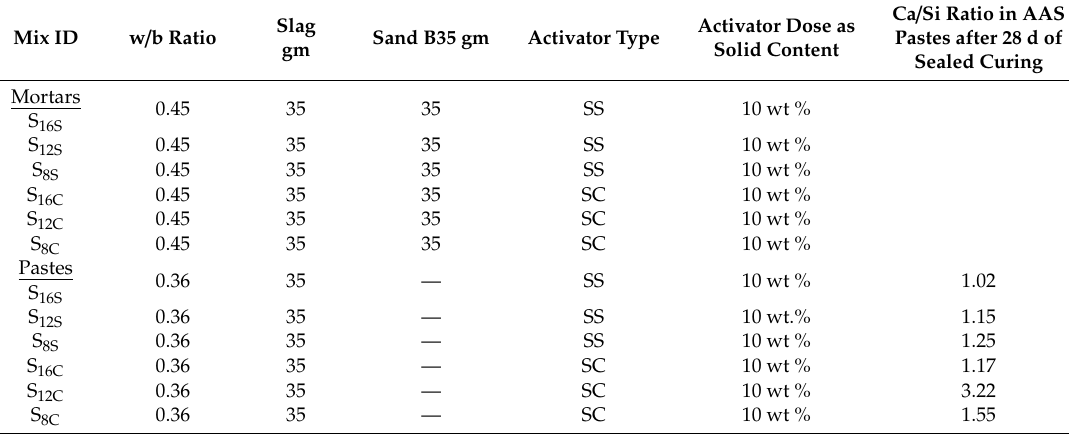
Figure 2. XRD analysis of the slags. Table 2. Mortars and pastes mix